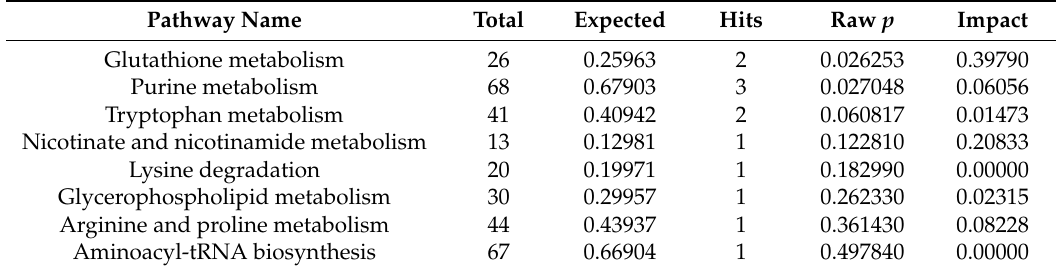
Table 3. Metabolic pathway analysis with